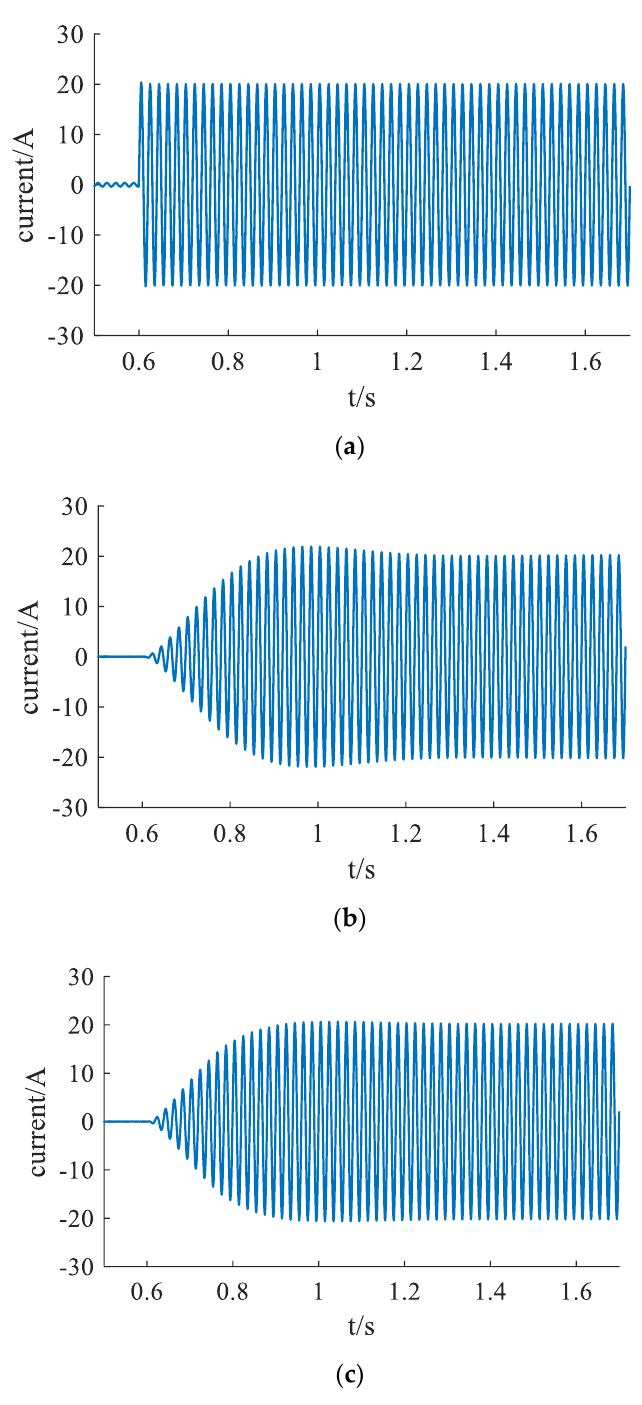
Figure 6. Current simulation waveforms of each control strategy: ( a ) MPC; ( b ) MPC-VSG; ( c ) MPC- VSG-RBF.